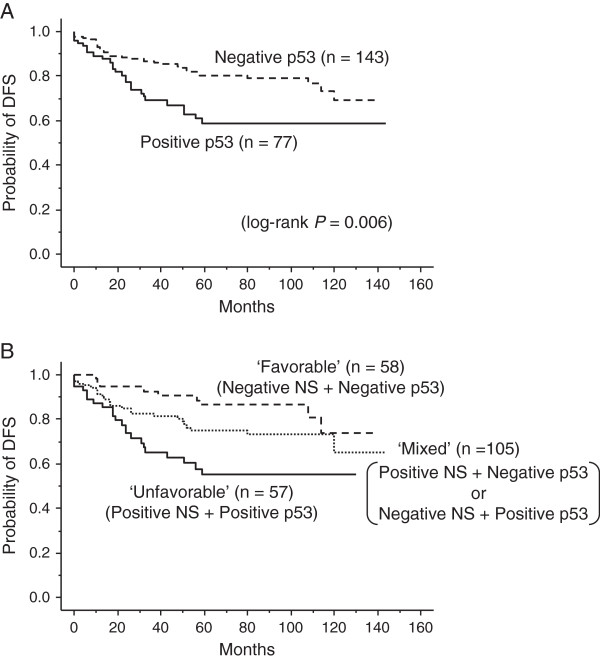
Prognostic impact of the combination status of NS and p53 in the patients with primary breast cancer. A. Disease-free survival (DFS) curves for the 77 patients with p53-positive tumors and for the 143 patients with p53-negative tumors. These two curves differ significantly (P = 0.006). B. This figure shows three disease-free survival (DFS) curves: for the 57 patients with NS-positive and p53-positive tumors (‘unfavorable group’), for 105 patients comprising 20 NS-negative and p53-positive tumors and 85 NS-positive and p53-negative tumors (‘intermediate’ group), and for 58 patients with NS-negative and p53-negative tumors (‘favorable’ group). The unfavorable group has significantly shorter DFS time than the intermediate group or the favorable group (log-rank test P = 0.034 and P = 0.0007, respectively).